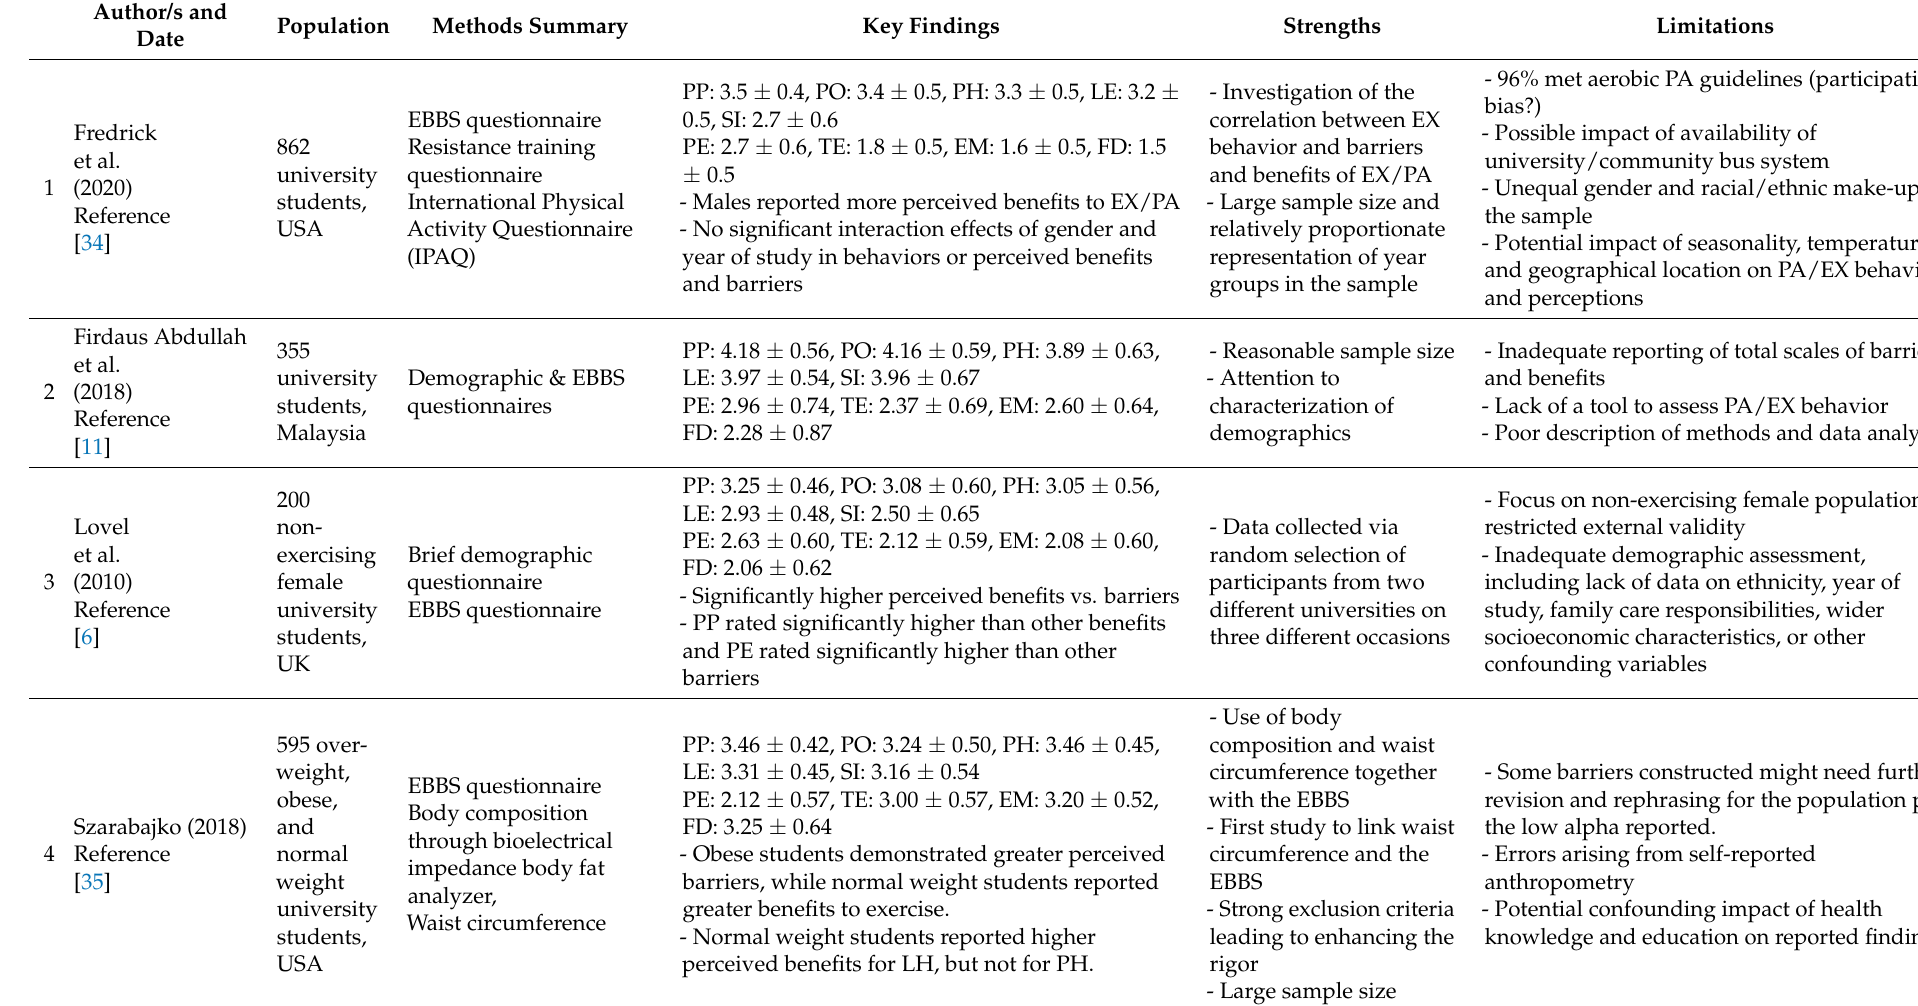
Table 1. Summary of the literature on the perception of the benefits and barriers of physical activity with methodology and population comparable to the current